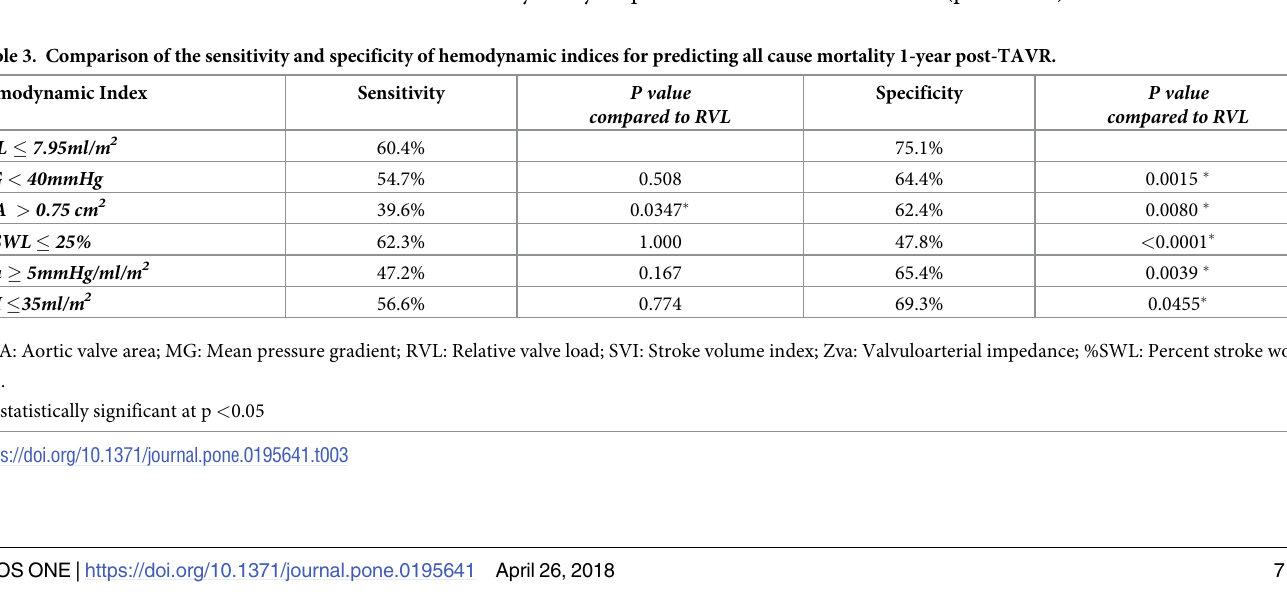
AUC: Area under the curve; AVA: Aortic valve area; MG: Mean pressure gradient; RVL: Relative valve load; SVI: Stroke volume index; Zva: Valvuloarterial impedance; %SWL: Percent stroke work loss. (cid:3)